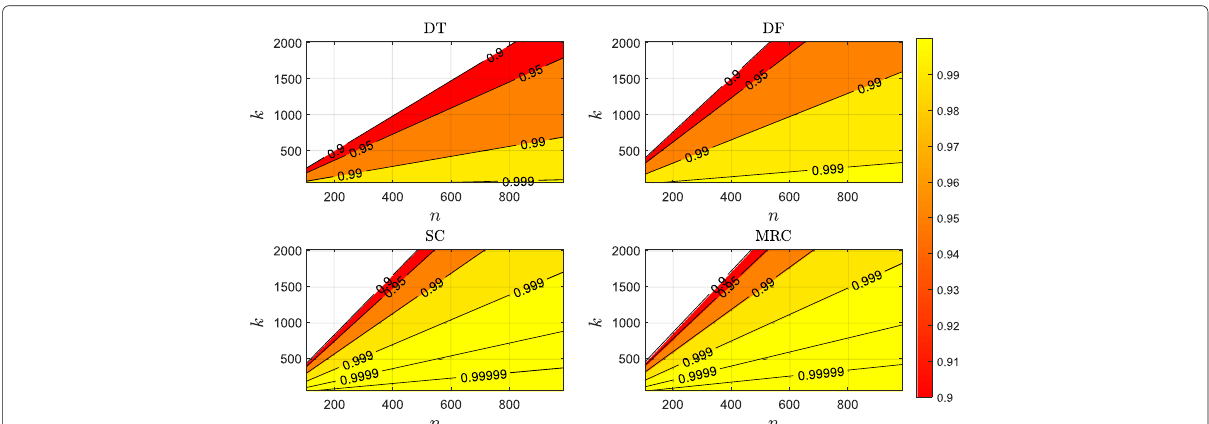
Fig. 4 Probability of successful transmission as a function k and n . This figure compares the impact of coding of on the performance of cooperative schemes, namely DF, SC, and MRC to direct transmission. We show that MRC outperforms other studied cooperative scenarios in terms of reliability and coding